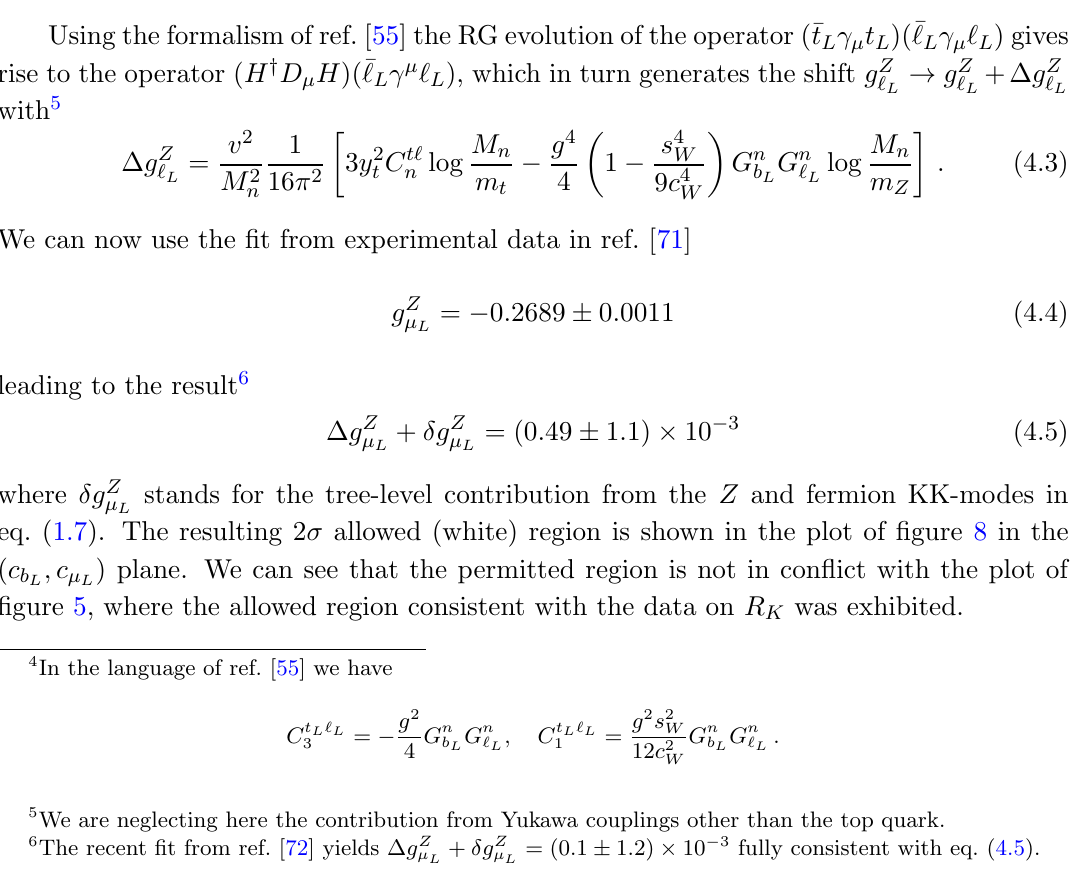
Figure 8 . Region in the plane ( c b where